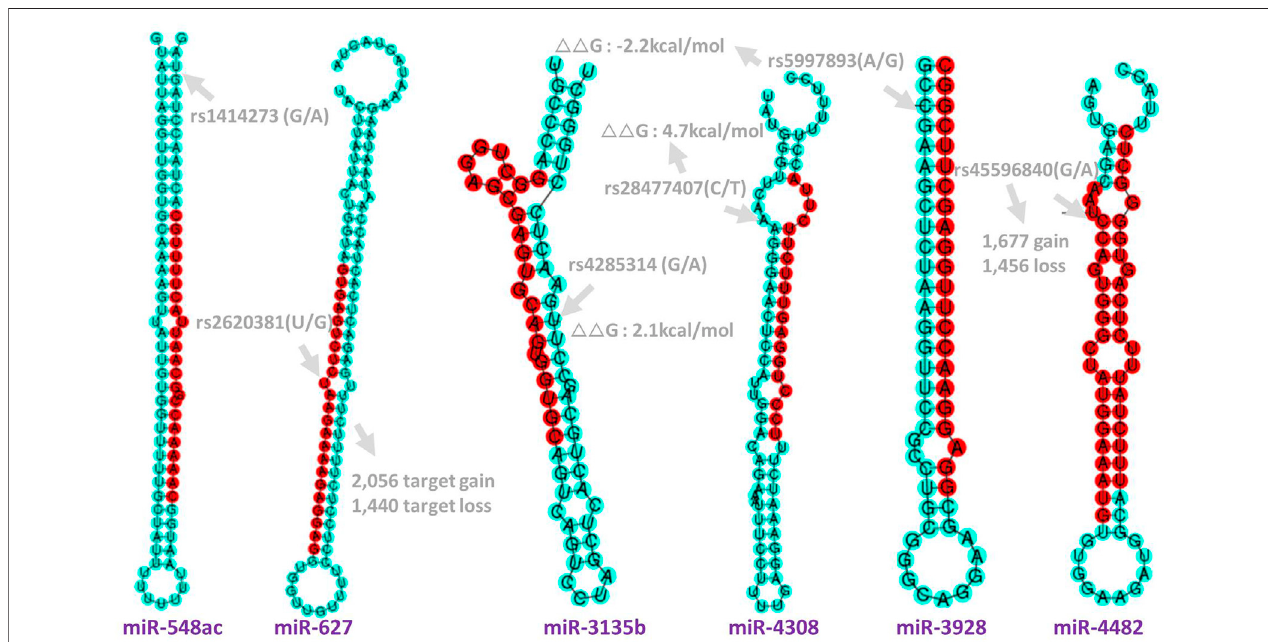
FIGURE 2| Genomic position and functional annotation to the signi fi cant SNPs in miRNAs. rs1414273 (C/T) in miR-548ac ; rs2620381 (A/C) in miR-627 -5p which cause 2,056 target gain and 1,440 target loss. rs4285314 (G/A) in miR-3135b; rs28477407(C/T) in miR-4308 ; rs5997893 (A/G) in miR-3928-5p and rs45596840 (G/A) in miR-4482-5p which will cause 1,677 target gain and 1,456 target loss. Target gain or loss were imputed by miRNA-SNP database (Gong et al., 2015) (see method).